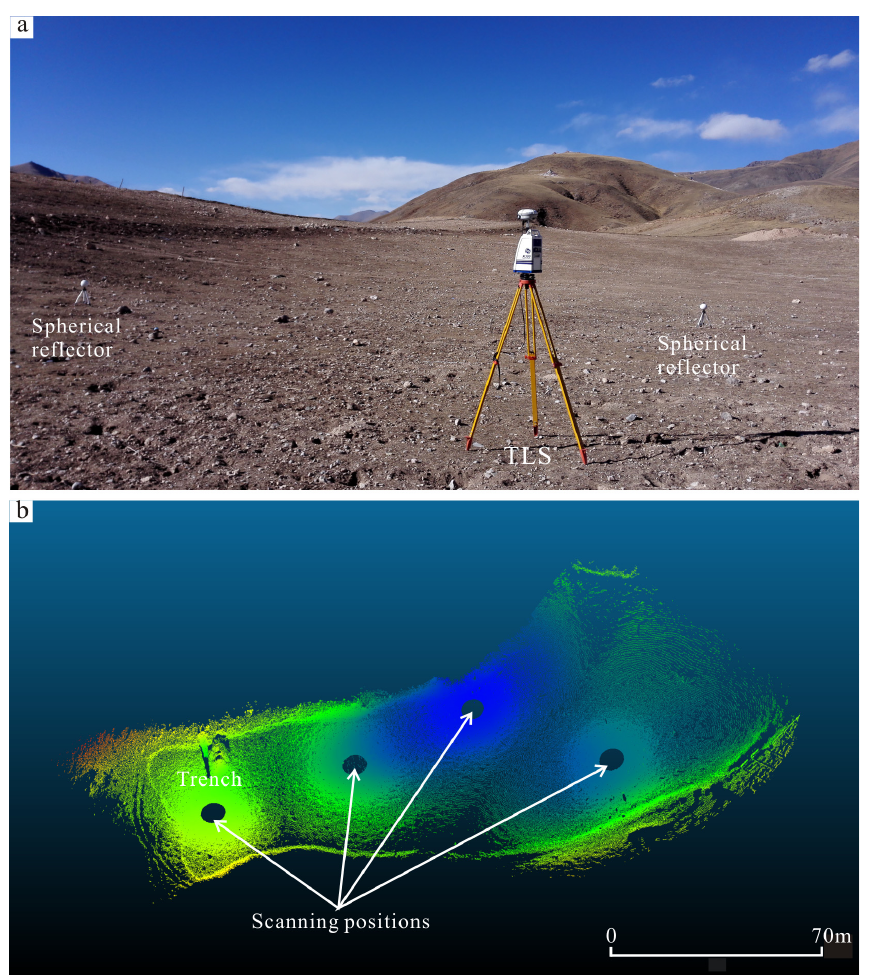
Figure 3. TLS acquisition. ( a ) TLS. ( b ) 3D point clouds.